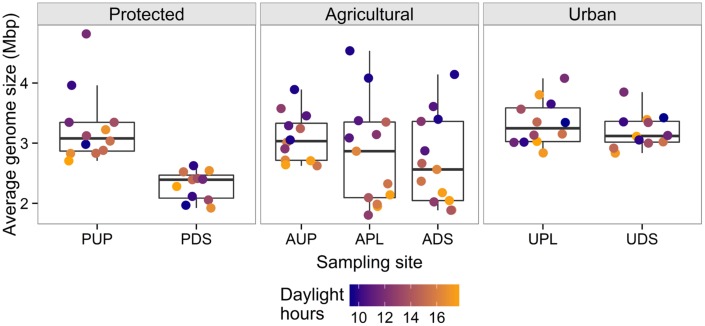
Average genome size (AGS) across sampling sites, colored by daylight hours, illustrating correlations within the agricultural watershed. Points represent samples and are jittered on the x-axis for visibility. The agriculturally affected sites (APL, ADS) have the largest ranges of values. There is a significant negative correlation between AGS and daylight hours in all sites in the agricultural watershed and a corresponding trend in PUP.